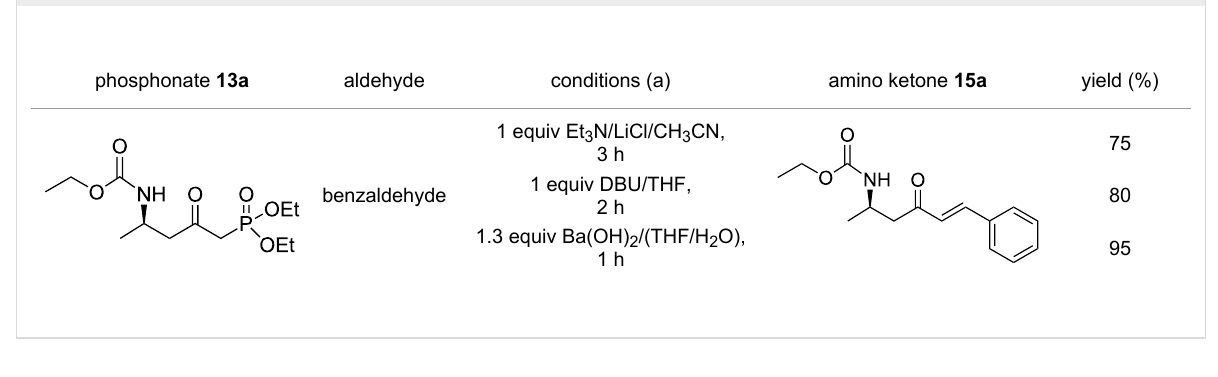
Table 2: Horner–Wadsworth–Emmons optimal conditions for 15a .